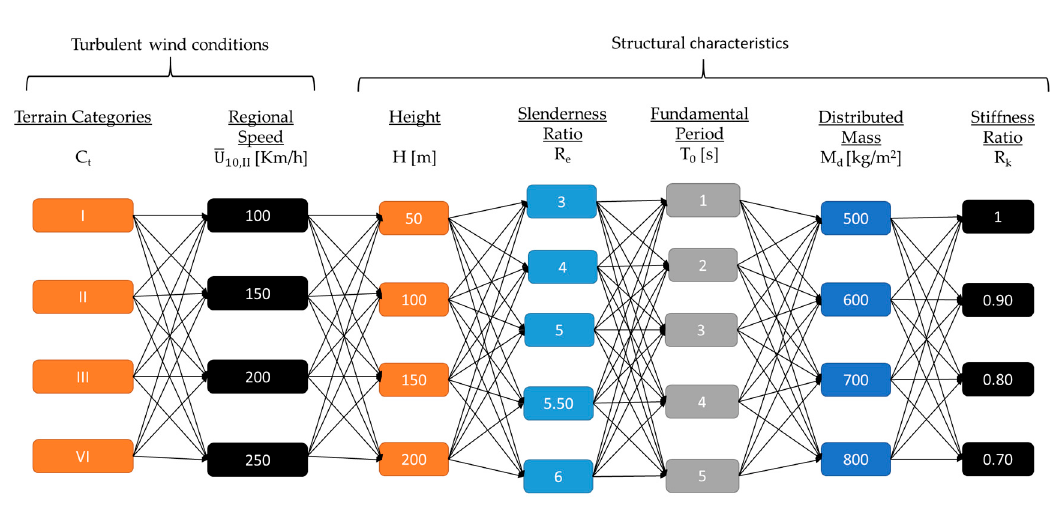
Figure 5. Parameters for definition of the structures and dynamic wind loads.